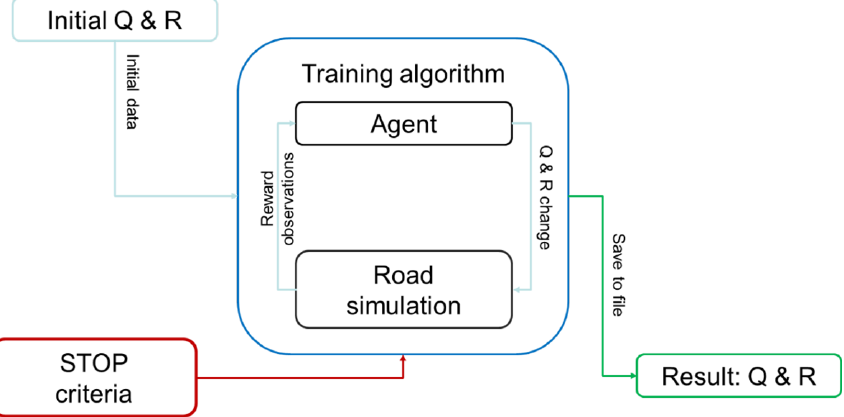
Figure 3. The architecture of the system for selecting quality matrix settings Q and resources R